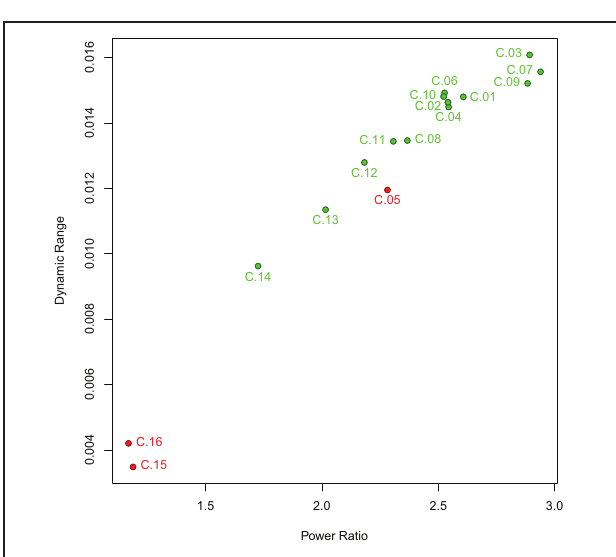
components are drawn in green, artifacts are drawn in dark gray. It can be seen that the clusters with lower consistency (i.e., C.12–C.16) are quite distinct from a more homogeneous cluster of higher consistency components.